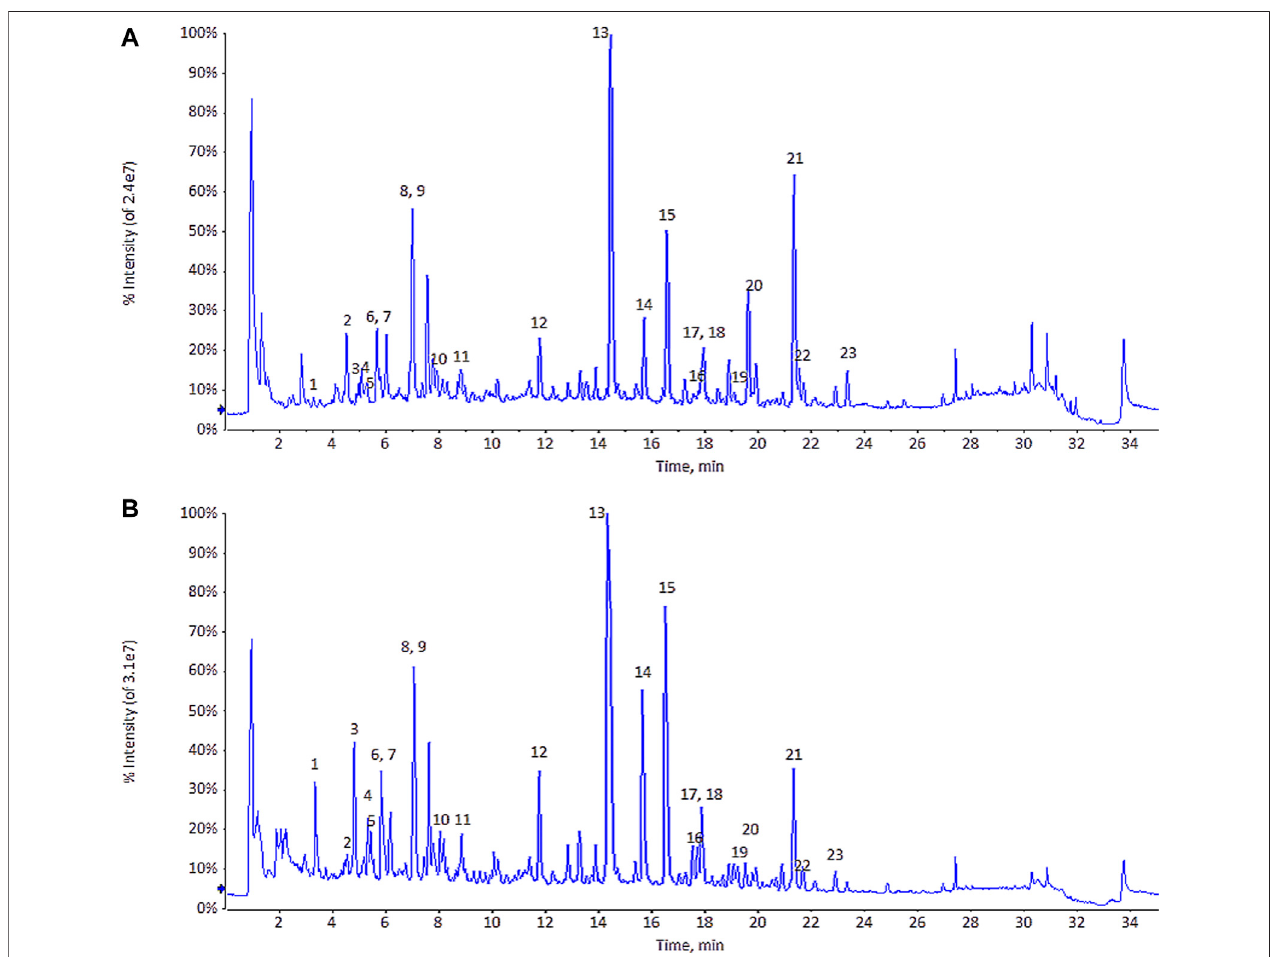
FIGURE 2 | The total ion chromatogram (TIC) of ULRA (A) and YF (B) . ULRA, unprocessed lateral root of Aconitum carmichaelii ; YF, Yinfupian.